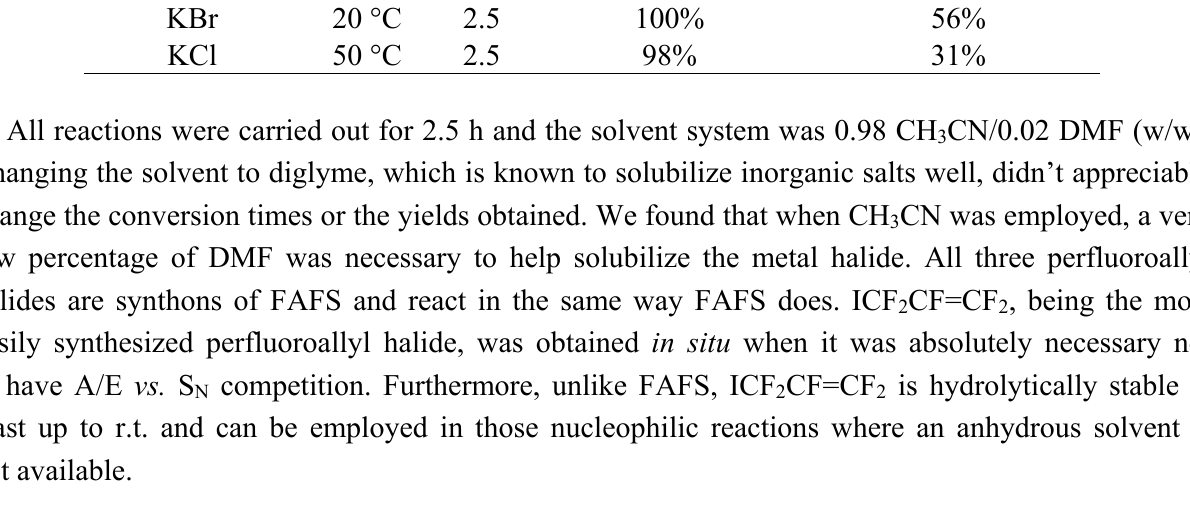
Table 10. Addition of COF to FAFS—Yields, selectivities and side-reaction products as a 2 function of reaction temperature and solvent (ACF = Acryloyl fluoride, CF